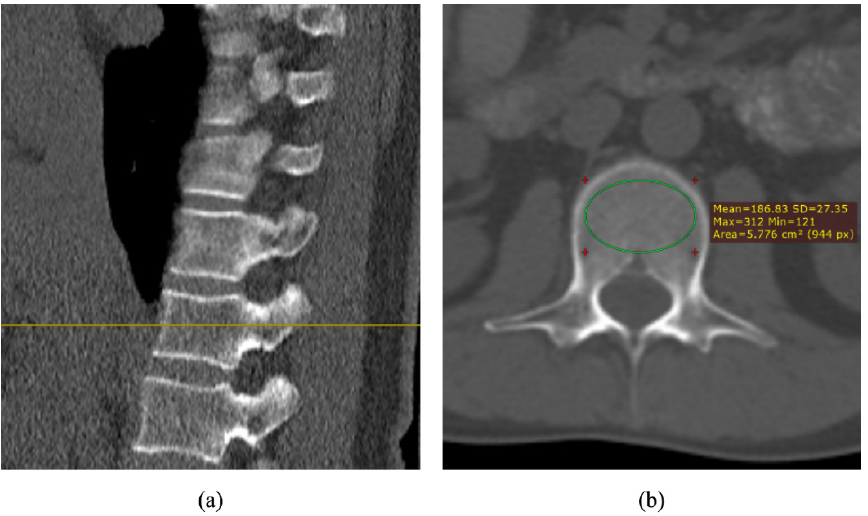
Figure 1. ( a ) Selection of the cross-sectional image passing through the center of the vertebral body in the sagittal plane and ( b ) circling the ROI in the cross-sectional image to include the trabecular bone.